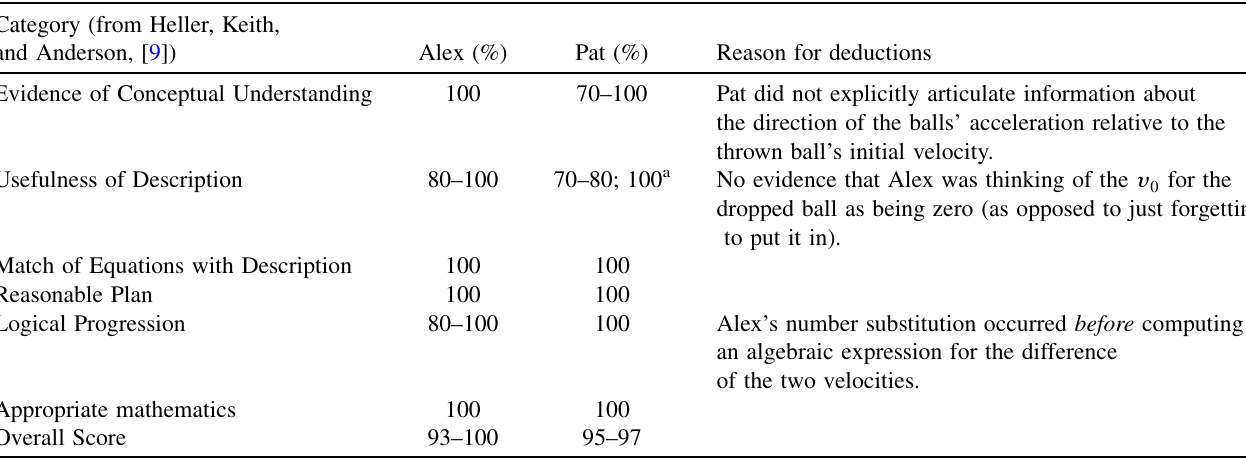
TABLE II. Pat and Alex were scored according to two rubrics. Summary of the Heller, Keith, and Anderson rubric assessment [9]. The Docktor and Heller rubric assessment is presented in the body of the